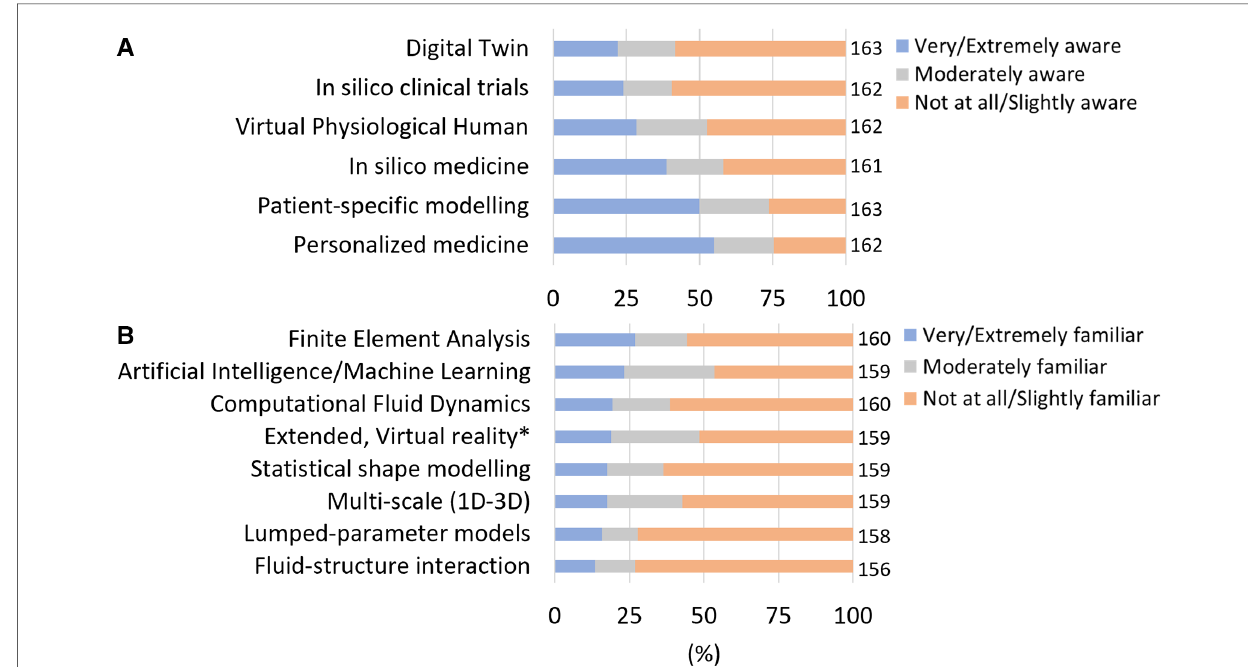
FIGURE 1 Awareness and familiarity with in silico terms and methodologies. ( A ) Level of awareness in in silico terms. Respondents who answered very and extremely aware (resp. Not at all aware and slightly aware) were grouped. ( B ) Level of familiarity with computational methods related to in silico technologies. Respondents who answered very and extremely familiar (resp. Not at all aware and slightly familiar) were grouped. The number of responses ( n ) amounting to 100% of the responses is reported on the right of each bar.